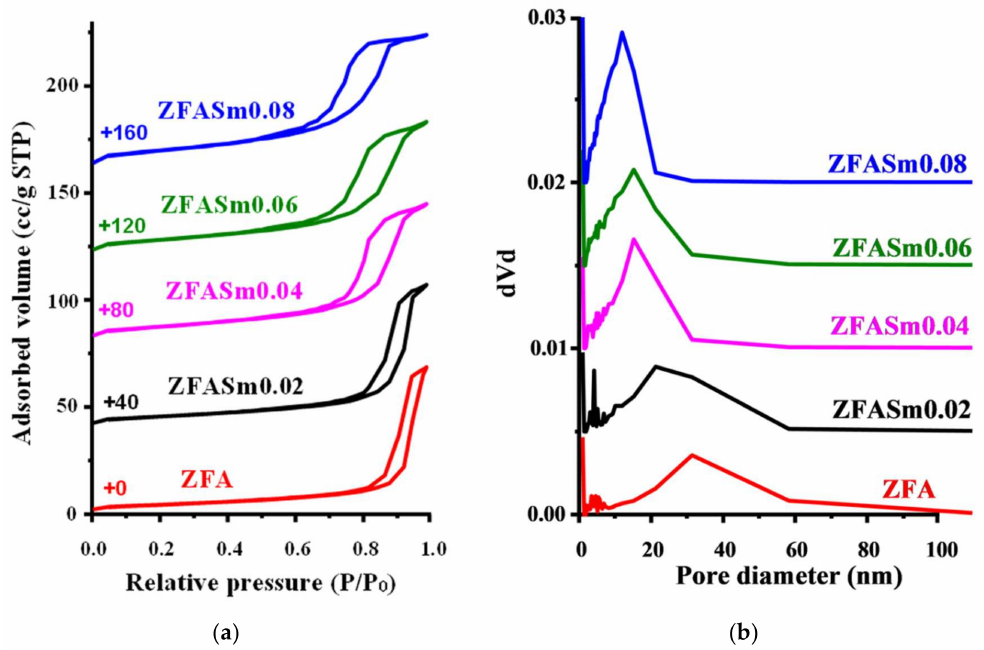
Figure 5. N 2 -sorption isotherms ( a ) and corresponding pore-size distributions ( b ) for ZnAlFe 1 − x Sm x O 4 (x = 0, 0.02, 0.04, 0.06, 0.08)